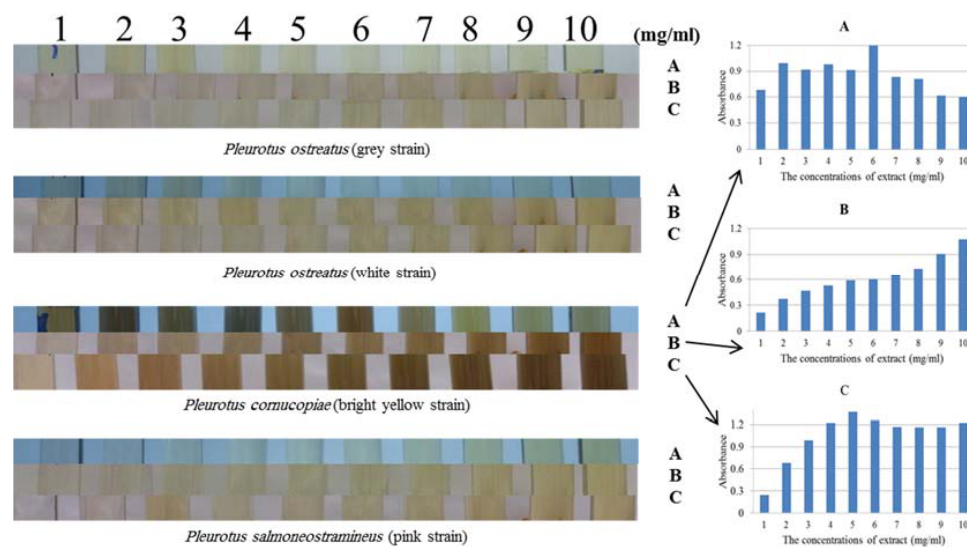
Fig 1. Colors with UV-Vis spectroscopy at 440 nm of AgNPs of P. cornucopiae var . citrinopileatus after seven days. Legend: A: extract of the dried mushroom that extracting by hot water was exposed to 5 ml of 1 Mm of AgNO 3 solution, B: extract of fresh mushroom that extracting by hot water was exposed to 5 ml of 1 Mm of AgNO 3 solution, C: extract of fresh mushroom that extracting by cold water was exposed to 5 ml of 1 Mm of AgNO 3 solution, mg/ml: concentrations of oyster mushroom extracts in 10 ml.